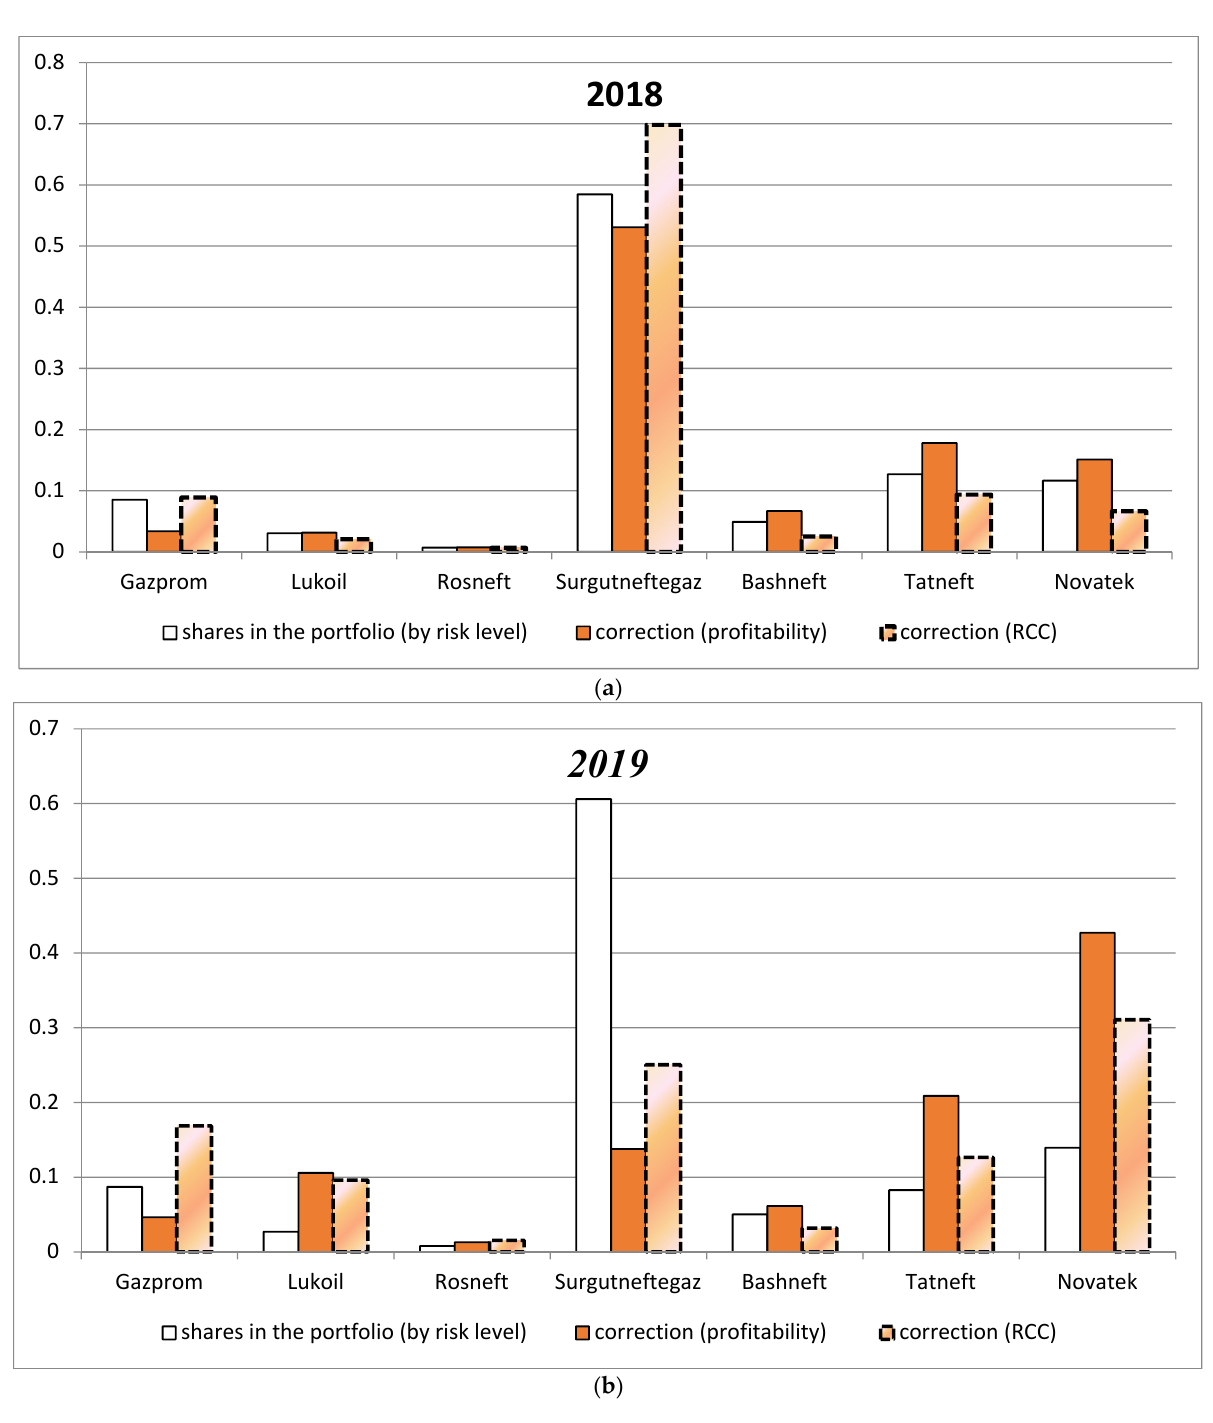
Figure 2. The structure of investments is based on the integral rating of competitiveness in dynamics, 2018 ( a ) and 2019 ( b ). The IR rating made it possible to develop a portfolio rating of the RCC obtained using the minimax model in correction mode by the level of profitability (Table 3) and rating (Figure 3).